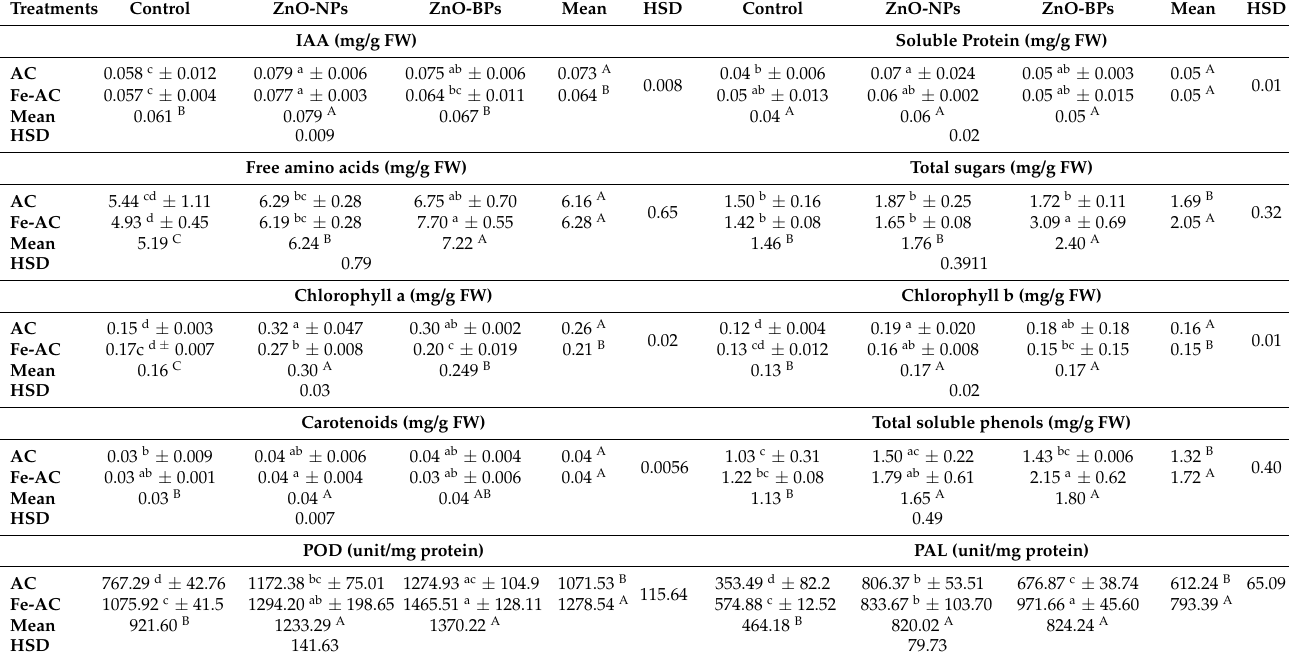
Table 3. Effect of activated charcoal (AC), Fe-modified activated carbon (Fe-AC), zinc oxide nanopar- ticles (ZnO-NPs), and zinc oxide bulk particles (ZnO-BPs) and their combinations on some physio- logical parameters of date palm cv. Medjool grown in vitro. Five plantlets for each treatment were utilized for 10 weeks of